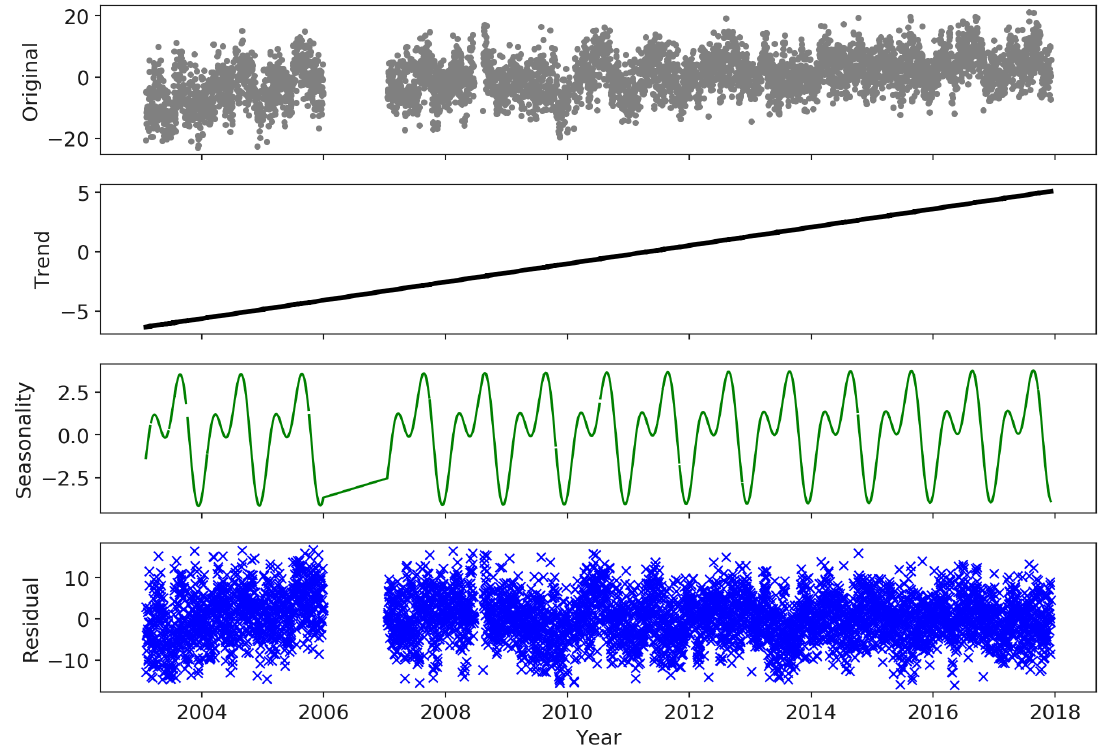
Figure 14. Signal decomposition for the vertical direction at Aboa between 1 February 2003 (2003–032) and 8 December 2017 (2017–342) [unit: